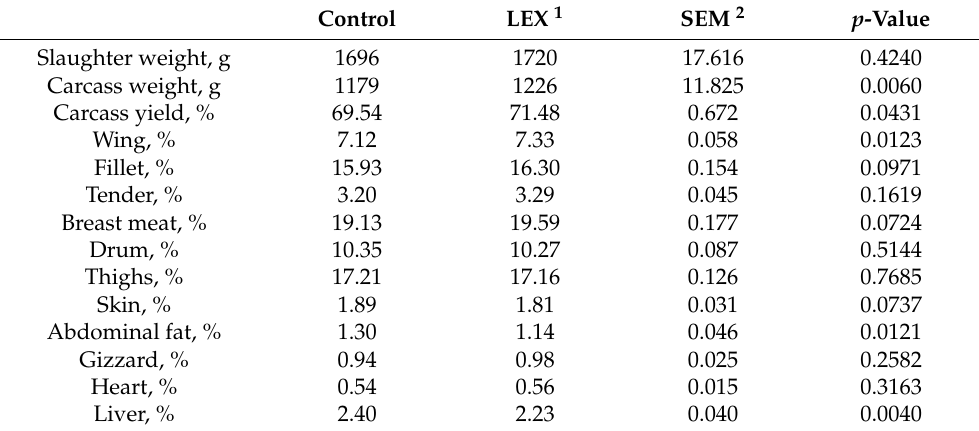
Table 3. Effect of the dietary supplementation of LEX to low-energy diets on slaughter weight and carcass traits of broilers in each experimental group.